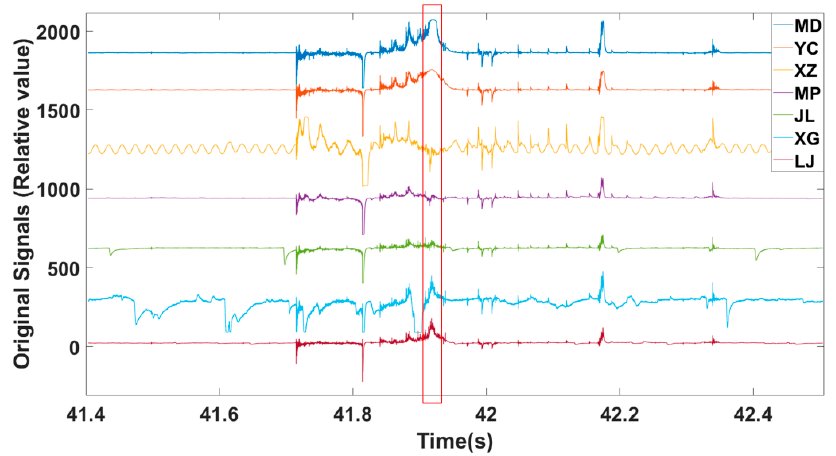
Figure 13. Original electric field signal over time from the seven stations for CG flash 000241.